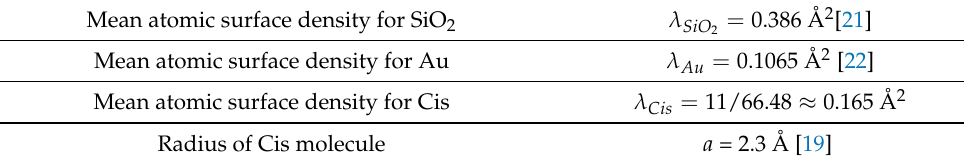
Table 2. Approximate numerical values for the constants used in this